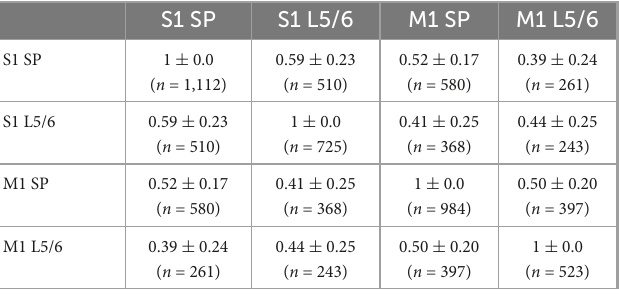
TABLE 5 Probability of coincident bursting estimated by S1Bf–S2 silicon probe pairs.